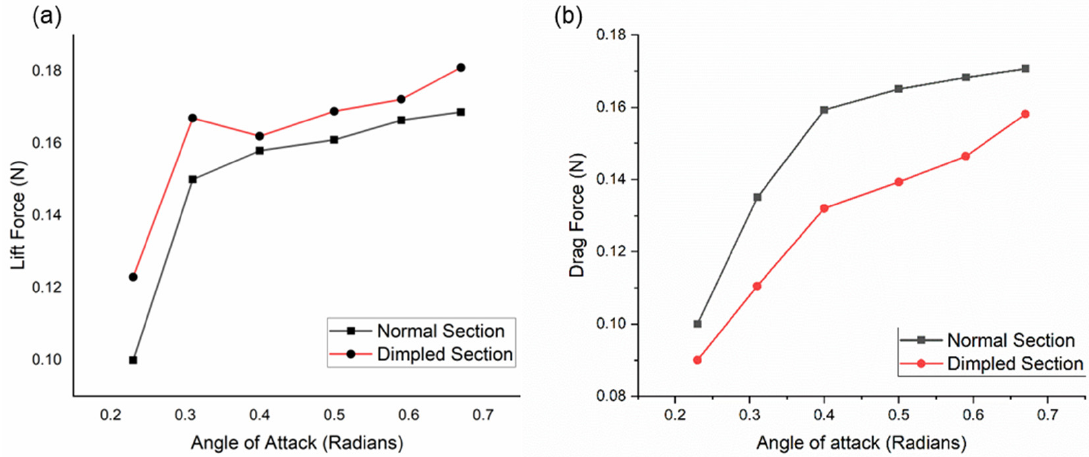
Figure 13. ( a ) Lift and ( b ) drag forces with changing AOA for the MRF approach.